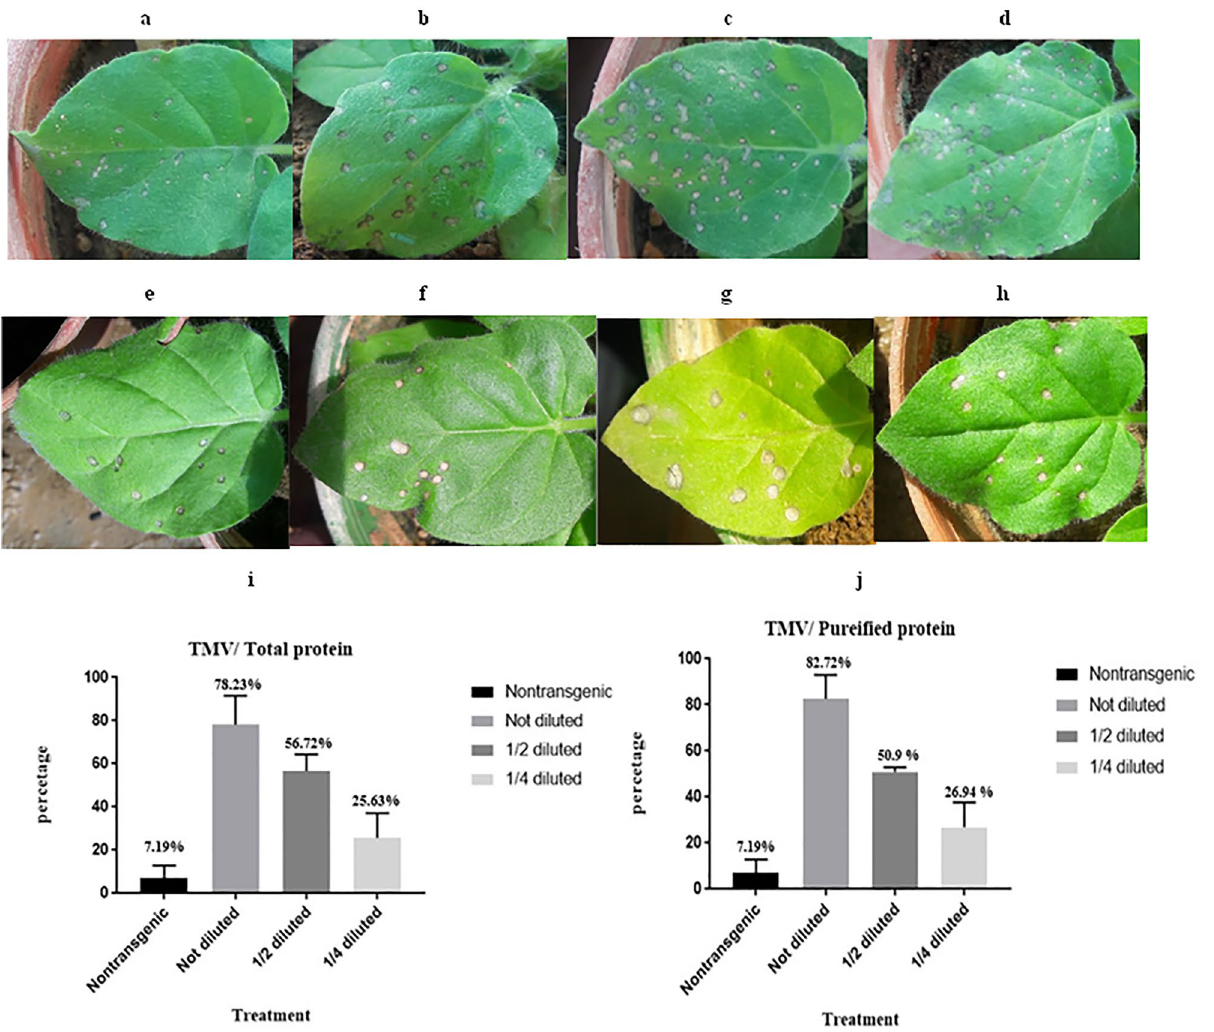
Figure 7. The simultaneous inoculation of N. glutinosa seedling with purified TMV and transgenic total protein in three dilutions, and purified TMV plus rMAP30 in three dilutions. Purified TMV plus non-transgenic total protein (negative control) (Table 3). There were 16 replicates for each test. (a) Test conducted with undiluted transgenic total protein. (b) Test conducted with one second diluted transgenic total protein. (c) Test conducted with one-quarter dilution of transgenic total protein. (d) Test conducted with non-transgenic total protein in undiluted state. (e) Test conducted with undiluted rMAP30. (f) Test conducted with one second diluted rMAP30. (g) Test conducted with one-quarter dilution r MAP30. (h) Test conducted with non-transgenic total protein in undiluted state. D4 indicates the day of symptoms observation. The virus and buffer existed in the right half of each leaf, as well as the protein and virus within the left half of each leaf were inoculated. (i,j) The viral infection controlling graph for rMAP30 in different dilutions versus non-transgenic protein. The highest control percentage was observed when the undiluted